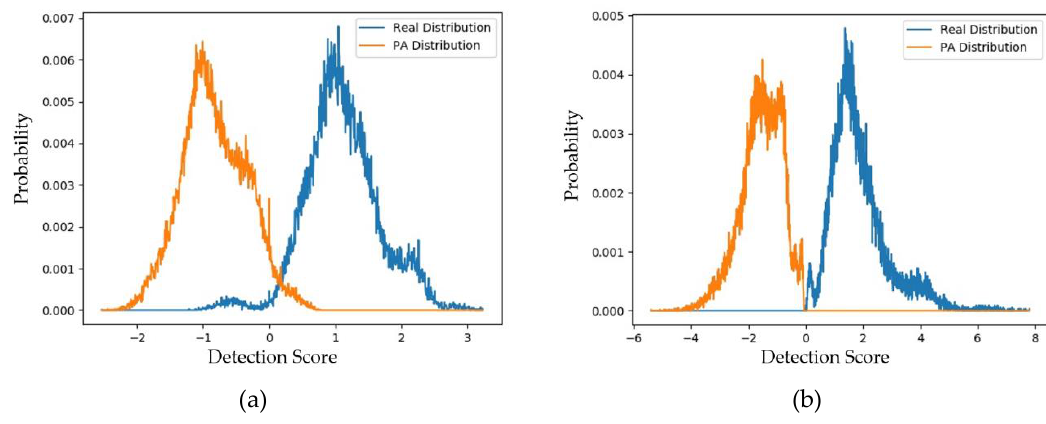
Figure 11. Distribution of detection scores of captured real versus captured PA images ( a ) using the handcrafted-based face-PAD method [50] and ( b ) using the deep-learning-based face-PAD method [15]. Table 10. padD measurements of generated PA images using Replay-mobile dataset.